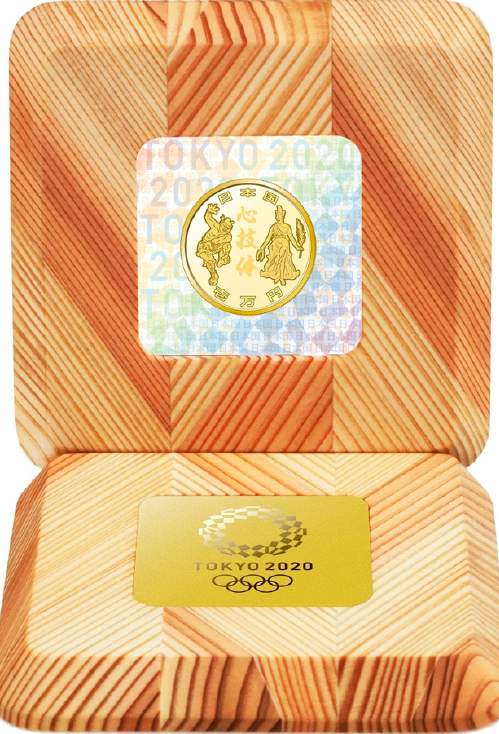
Figure 1. 10,000-yen gold proof coin issued as part of the Olympic and Paralympic Games Tokyo 2020 Commemorative Coin Programme (3rd issue, 2019) and offered for public purchase at 122,223 yen (roughly one-thousand euros). Reproduced with permission from Japan Mint and the International Olympic Committee (IOC).